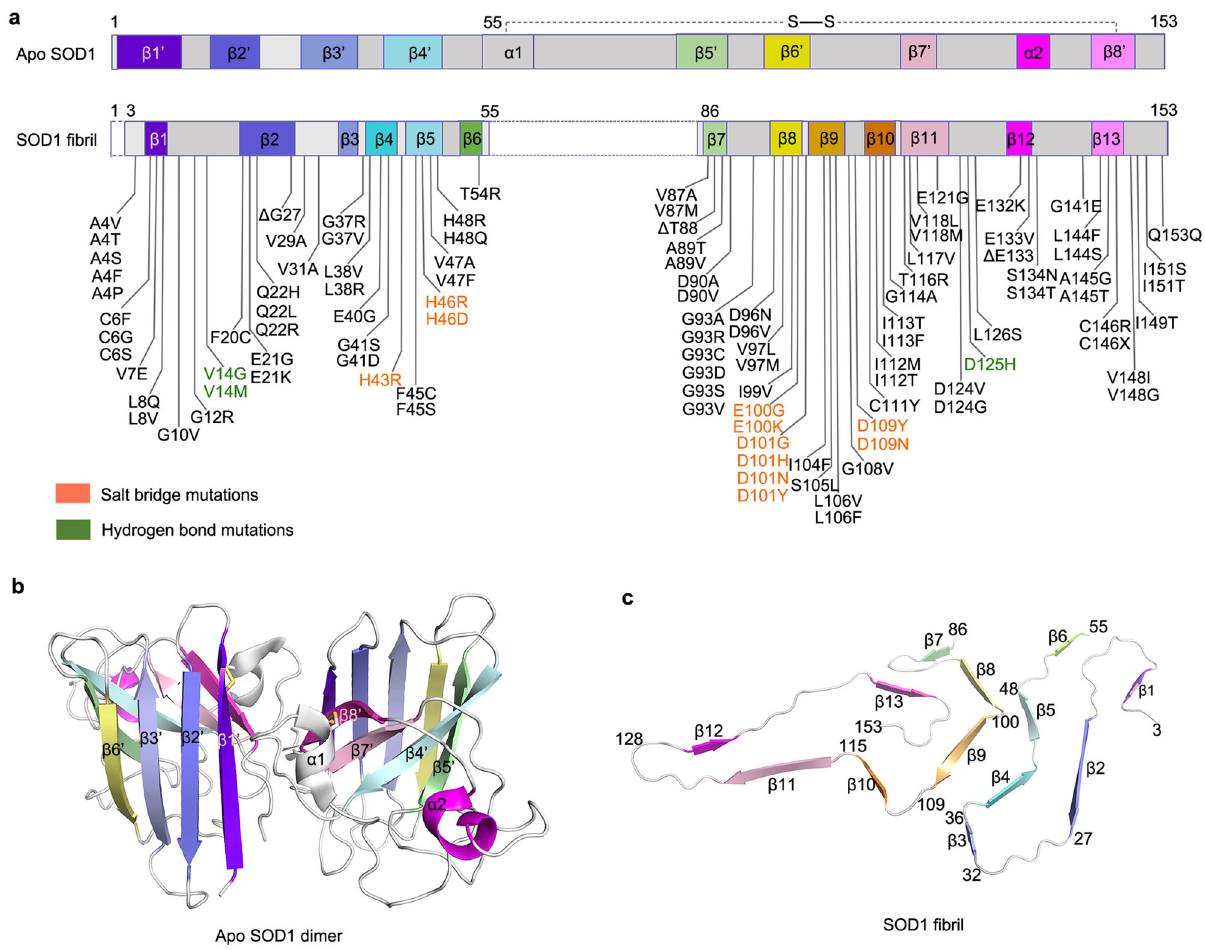
Fig. 4 Comparison of the structures of apo SOD1 dimer and SOD1 fi bril. a Sequence alignment of the full-length apo human SOD1 (1 to 153) monomer with eight β -strands colored violet ( β 1 ’ ), blue ( β 2 ’ ), light blue ( β 3 ’ ), light cyan ( β 4 ’ ), light green ( β 5 ’ ), yellow ( β 6 ’ ), pink ( β 7 ’ ), and light magenta ( β 8 ’ ), two α -helices colored gray ( α 1) and magenta ( α 2), and a single disul fi de bond between Cys 57 in α 1 and Cys 146 in β 8 ’ in each subunit 10 . Sequence alignment of the SOD1 fi bril core comprising residues 3 – 55 and 86 – 153 from full-length human SOD1 (1 to 153) with the observed thirteen β strands colored violet ( β 1), blue ( β 2), light blue ( β 3), cyan ( β 4), light cyan ( β 5), green ( β 6), light green ( β 7), yellow ( β 8), gold ( β 9), orange ( β 10), pink ( β 11), magenta ( β 12), and light magenta ( β 13). Dashed boxes correspond to residues 1 – 2 and residues 56 – 85, which were not modeled in the cryo-EM density. Among two hundred and sixteen mutations linked to familial ALS 1 – 5,8,17 – 22,25,26,29,44 – 50 (https://alsod.iop.kcl.ac.uk/), one hundred and eighty-two clinically identi fi ed mutations are located within the SOD1 fi bril core structure, in which one hundred and fi ve representative genetic ALS-related mutations are listed in a . Orange, salt bridge mutations; green, hydrogen bond mutations. b Ribbon representation of the structure of full-length apo human SOD1 (1 – 153) dimer with eight β -strands (to form a β -barrel), two α -helices, and a disul fi de bridge (yellow line) linking α 1 and β 8 ’ in each subunit (PDB 1HL4) 10 . c Ribbon representation of the structure of an SOD1 fi bril core containing one molecular layer and thirteen β -strands, in which the N-terminal segment contains six β strands ( β 1 – β 6) and the C-terminal segment contains seven β strands ( β 7 – β